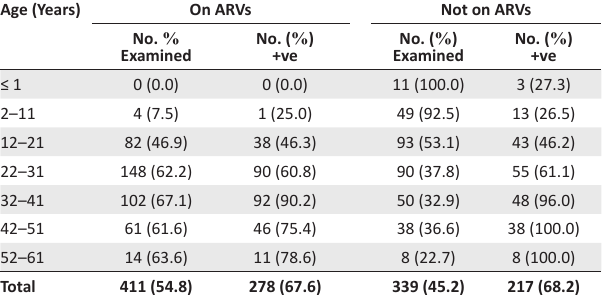
TABLE 2 : Prevalence of Microsporidiasis amongst HIV-positive patients by age and ARV status ( n = 750). Age (Years) On ARVs Not on ARVs